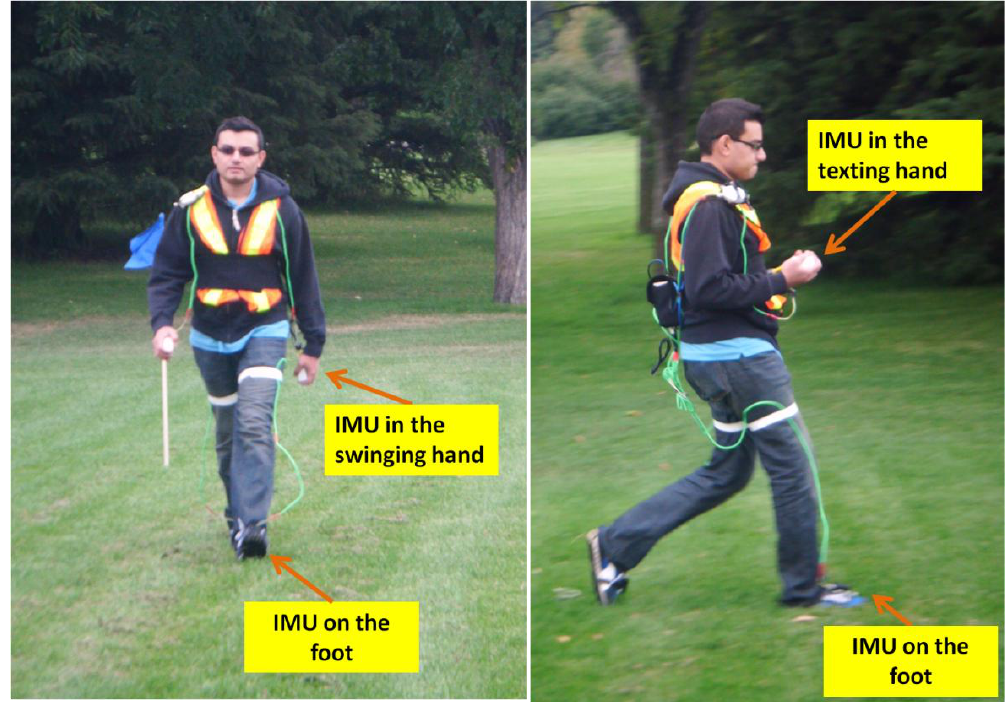
Figure 11. ( Left ) Test subject walking with the IMUs in his swinging hands; ( Right ) Test subject walking with the IMUs in his texting hands.